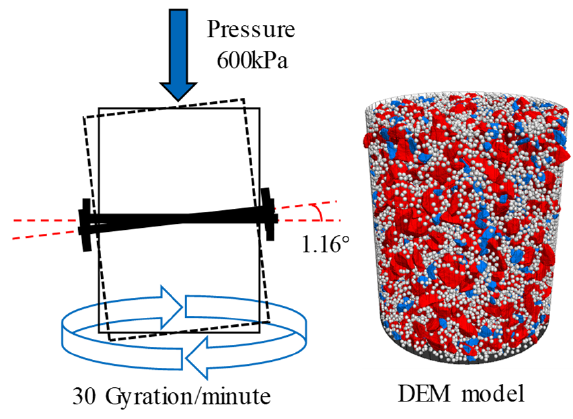
Figure 14. Simulation of asphalt mixtures with SGC.